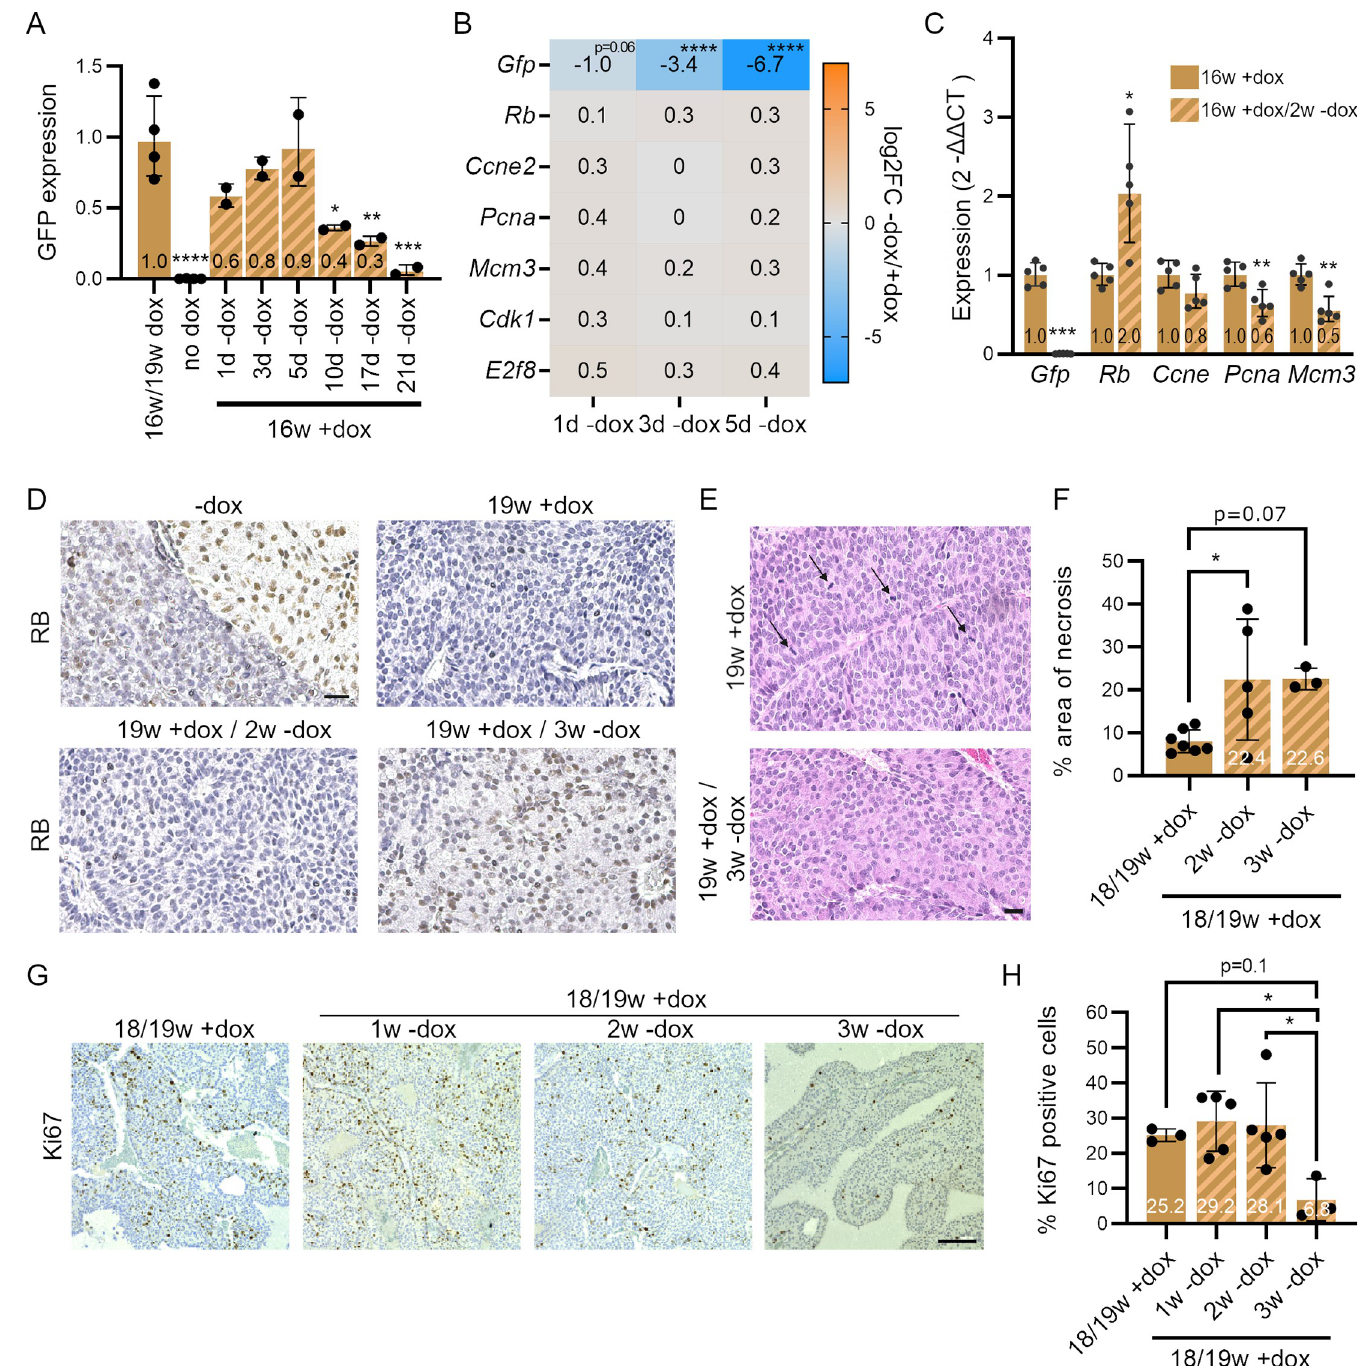
Fig 4. Kinetics of RB re-expression in vivo in sh Rb mice. A. GFP expression measured by quantitative immunoassay on protein extracts from the liver of dox-treated sh Rb mice at different time-points (w, weeks) after doxycycline (dox) removal. Signal intensity was normalized to HSP90 (one-way ANOVA, significance is indicated compared to 16w/19w +dox: � , p < 0.05; �� p < 0.01; �� , p < 0.01; ���� , p < 0.0001). B. Expression changes of Gfp and selected cell cycle genes in pituitary RNA from sh Rb mice, 1, 3 and 5 days after dox removal compared to dox-treated samples. Expression was determined using RNA-seq (DEseq2: ���� , p.adj. < 0.0001). C. Expression changes of Gfp and selected cell cycle genes by RT-qPCR in pituitary RNA from dox-treated sh Rb at 16 weeks compared to mice after 2 weeks off dox (two-tailed t-test: � , p < 0.05; �� p < 0.01). D. Representative immunostaining images for RB on pituitary section from control mice (-dox), dox-treated sh Rb mice (19w +dox), and after dox release (2 or 3 weeks). Scale bar, 20 μ m. E. Representative hematoxylin and eosin (H&E) images of pituitary sections from 19w +dox mice and 19w +dox mice after 3 weeks off dox. Arrows point towards mitotic figures that can be observed in the 19w dox-treated samples. Scale bar, 20 μ m. F. Quantification of necrotic tissue area on section from pituitary tumors from dox-treated sh Rb mice or 2 and 3 weeks off dox (one-way ANOVA analysis, significance is indicated compared to 18w/19w +dox: � ,